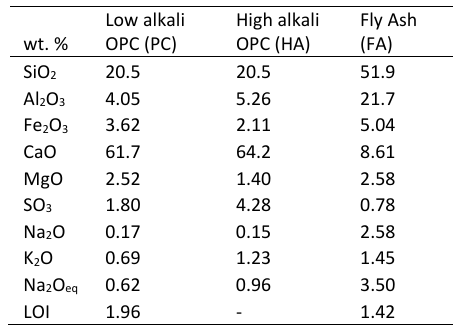
Table 1. Oxide composition of cements and fly ash. wt.